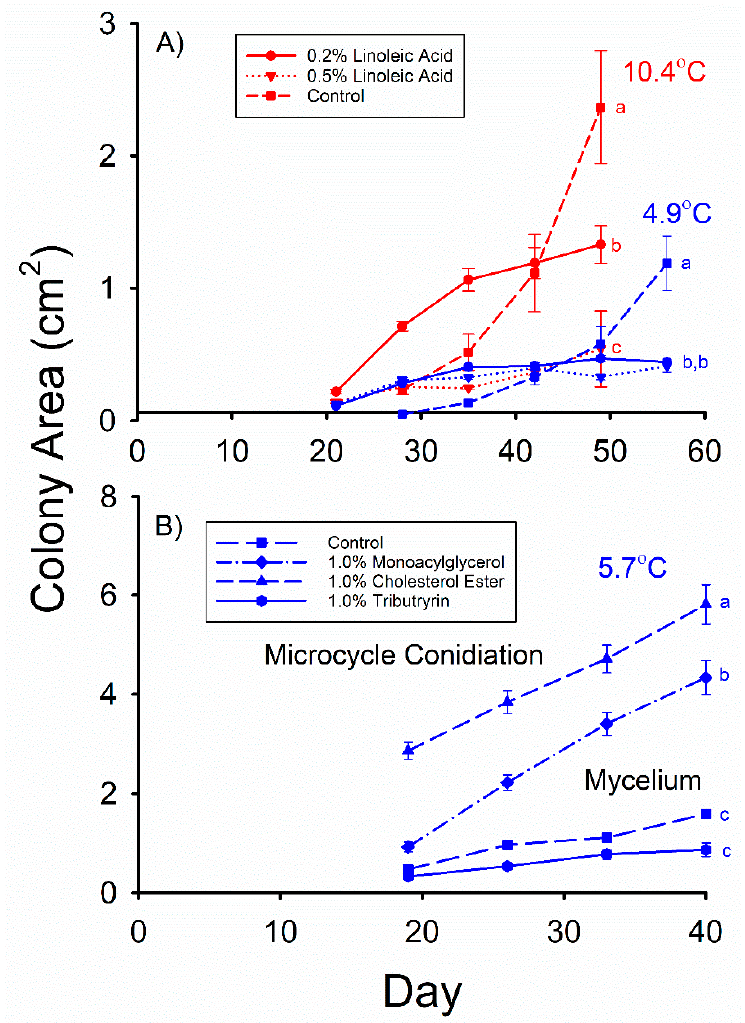
Figure 3. Mean (± SE) surface areas of Pseudogymnoascus destructans colonies at various stages of growth in: ( A ) Experiment 5, and ( B ) Experiment 6 at T a = 4.9–5.7 (blue symbols) and 10.4 °C (red symbols). Means within the same T a treatment and experiment sharing a common lower-case letter are not significantly different at the p < 0.05 level.